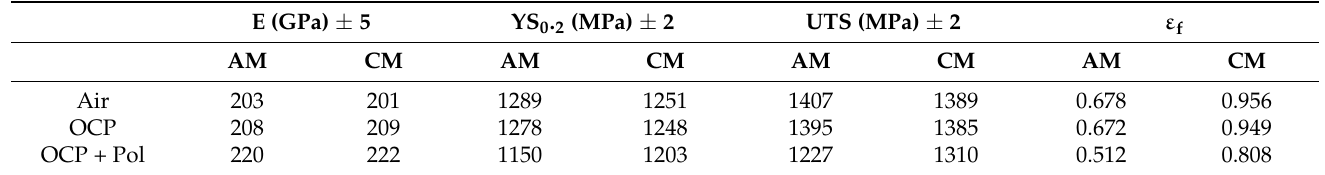
Figure 7. SEM observation of the fracture surface of an AM sample after an EAC test (sample main- tained at the OCP and then polarised): ( a ) General view; ( b ) focus on a small crack initiated on pits (white arrow).